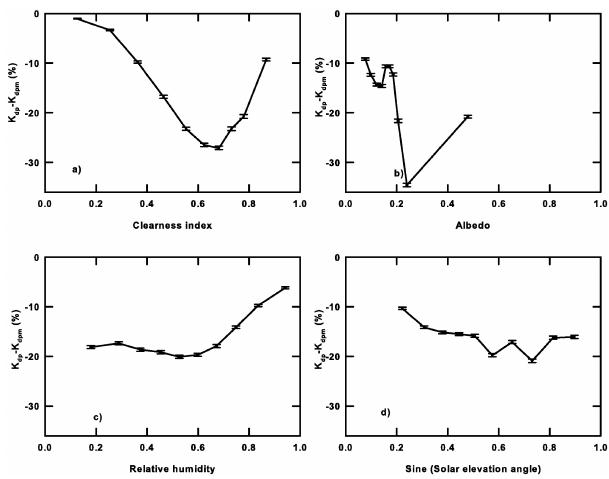
Figure 4. Percentage differences between measured and modeled diffuse radiation as a function of predictor variables.